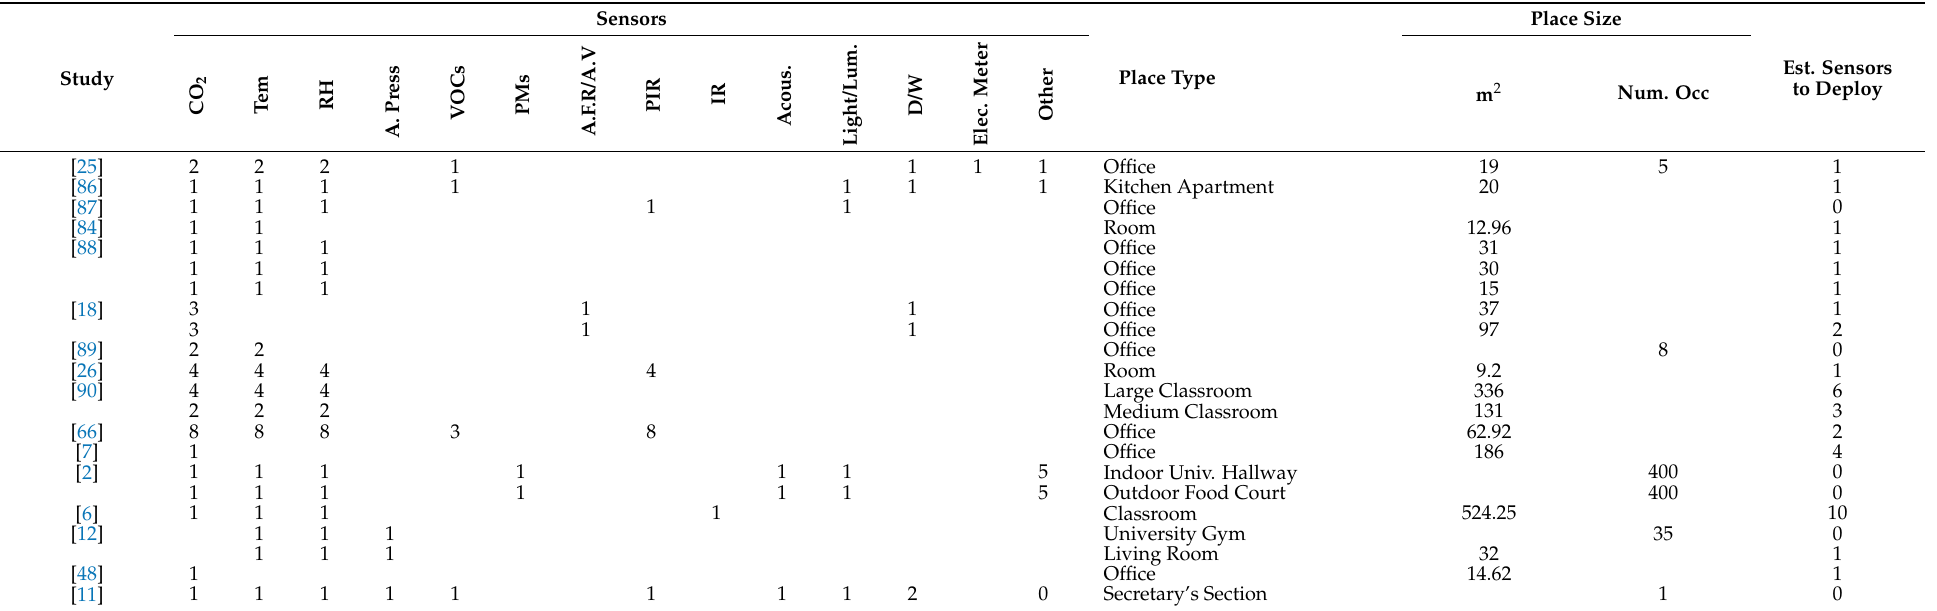
Table A2. Resume of the sensors deployed, place, place dimension, and theoretical estimation of the sensors to